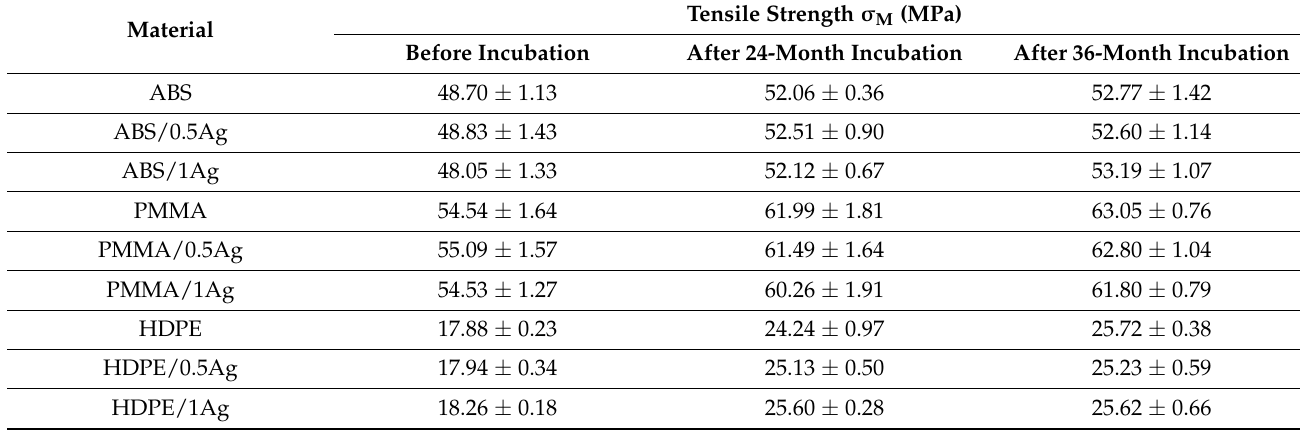
Table 4. Results of the tensile strength of polymers and composites modified with 0.5 wt.% and 1.0 wt.% AgNPs.